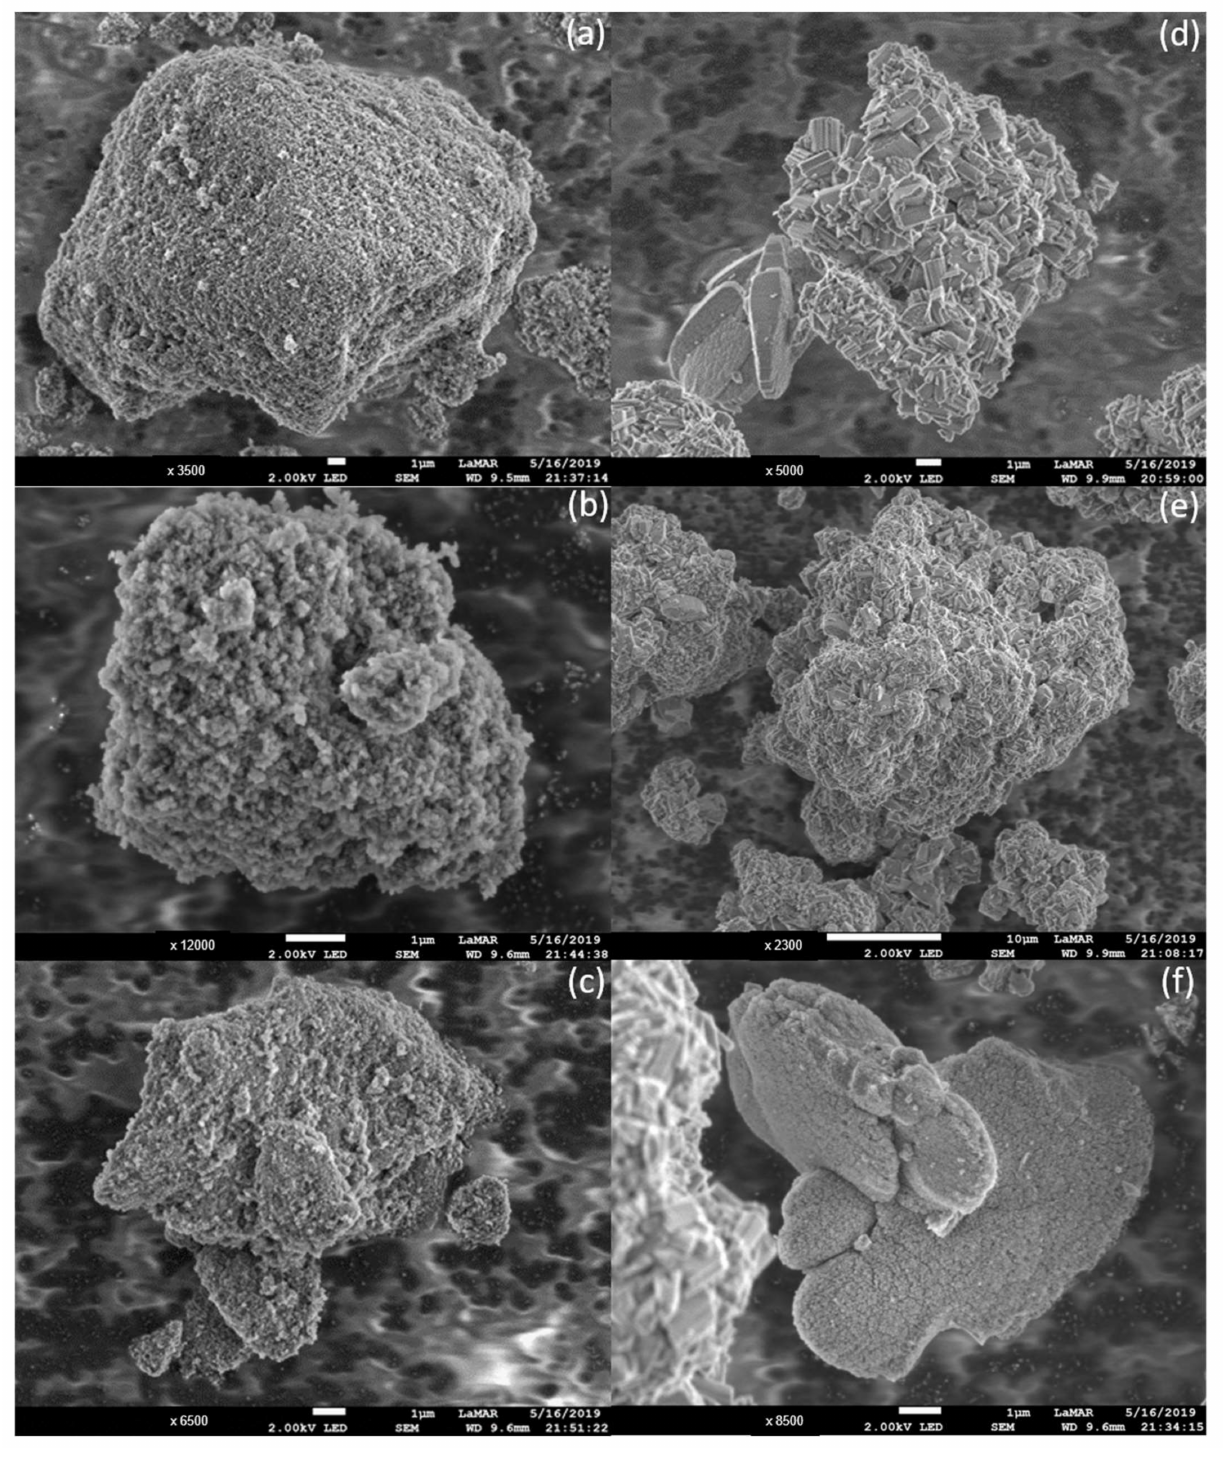
Figure 3. SEM images for the ( a – c ) beta and ( d – f ) mordenite